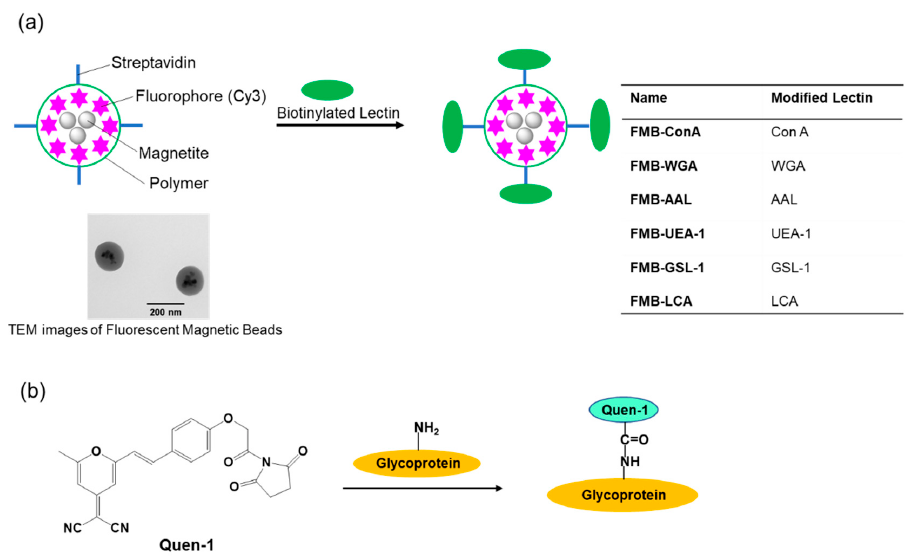
Figure 1. Schematic representation of the immobilization of lectins onto the surface of fluorescent magnetic beads (designated as FMB-Lectin; Lectin: Con A, WGA, AAL, UEA-1, GSL-1, or LCA) ( a ) and the labeling reaction between fluorescent quenchers and glycoproteins ( b ).